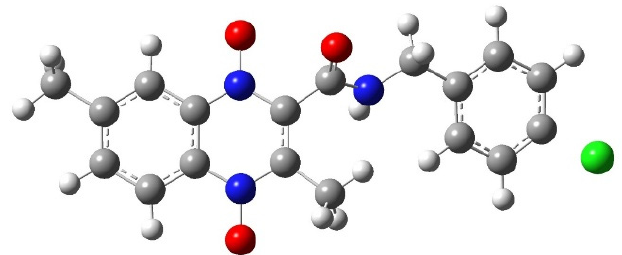
Figure 3. The carbon—chlorine bond length increases to 1.87 Å for Compound 20 during the optimization of the dianion species. Chemical structure created in GaussView 5 [34] and optimized in Gaussian 09 [37]. Carbon is shown in grey, hydrogen in white, nitrogen in blue, oxygen in red, and chlorine in green. Table 2. The predicted half-cell reduction potentials for the 1,4-di-N-oxide quinoxaline-2-carbox- amide derivatives calculated using Gaussian 09 at the DFT: B3LYP/lanl2dz level of theory [32,37].